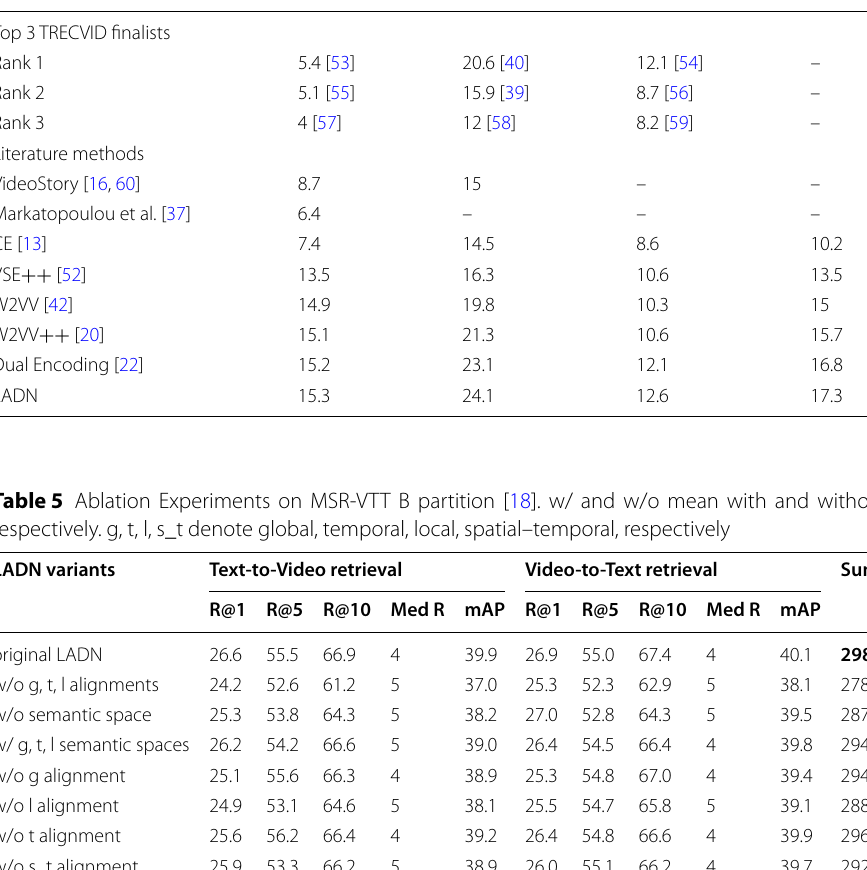
w/ g, t, l semantic spaces 26.2 54.2